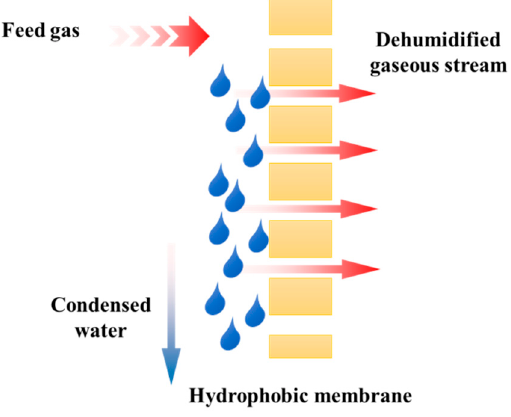
Figure 1. Principle of membrane condenser process.